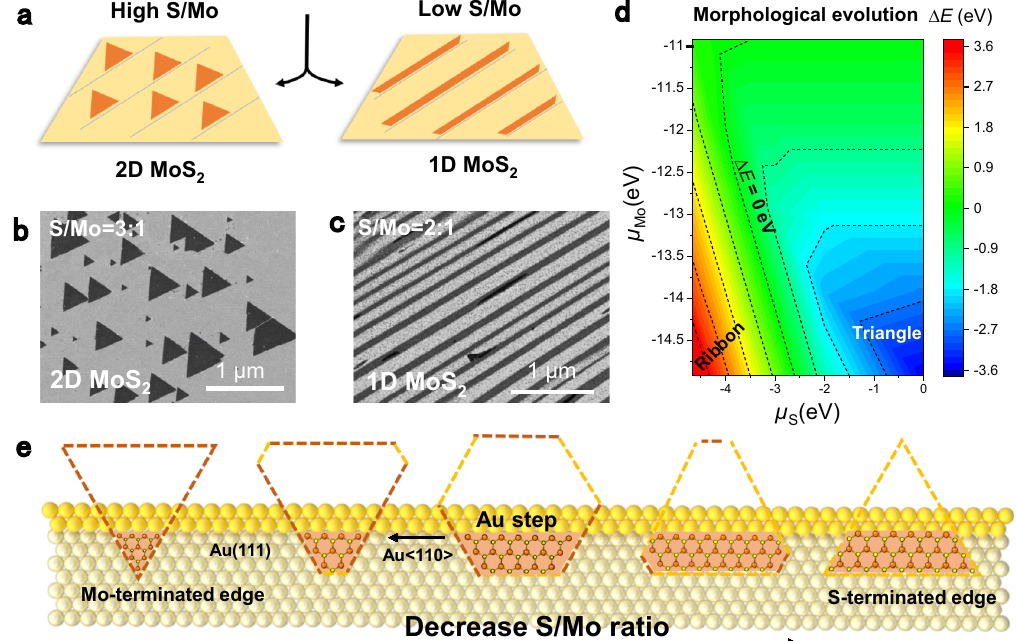
Fig. 1 Morphological evolution of monolayer MoS 2 from triangular to ribbon-like shaped domains. a Schematic illustration of the morphological evolution of MoS 2 . b , c SEM images of 2D monolayer MoS 2 triangles ( b ) and 1D ribbons ( c ) achieved at different S/Mo ratios. d Nucleation barrier ( Δ E ) difference mapping between S-zz and Mo ’ -zz edges under different chemical potentials of Mo ( μ Mo ) and S ( μ S ). For the case of high μ S and low μ Mo (bottom right region), the nucleation barrier of S-zz is smaller than that of Mo ’ -zz edge ( Δ E < 0), Mo ’ -zz edge is the dominating edge and the resulted MoS 2 fl ake presents a triangle shape. As μ S decreases ( Δ E > 0, bottom left region), the S-zz edge becomes the dominating edge and the resulted MoS 2 fl ake shows quasi ribbon-like shape. e Schematic view showing the morphology variations of monolayer MoS 2 islands with decreasing the S/Mo ratio. Orange and yellow spheres indicate Mo and S atoms, while the orange and yellow lines represent Mo and S terminated edges,